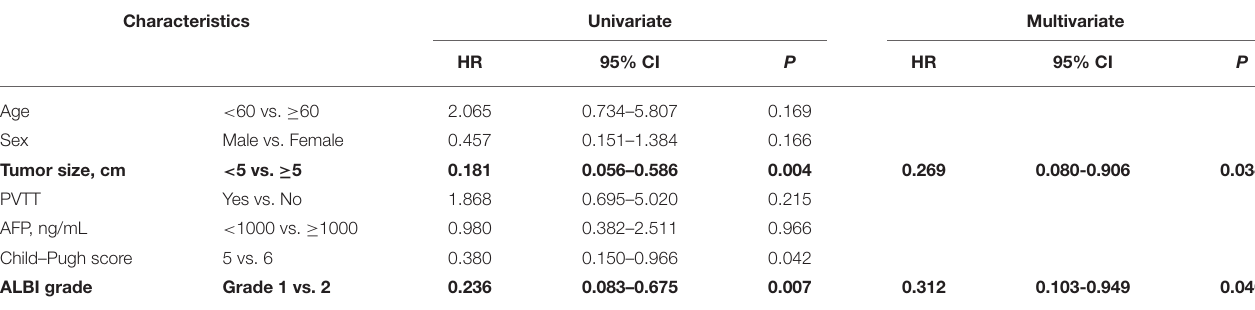
TABLE 2 | Factors associated with overall survival in 33 patients treated with nivolumab monotherapy. Characteristics